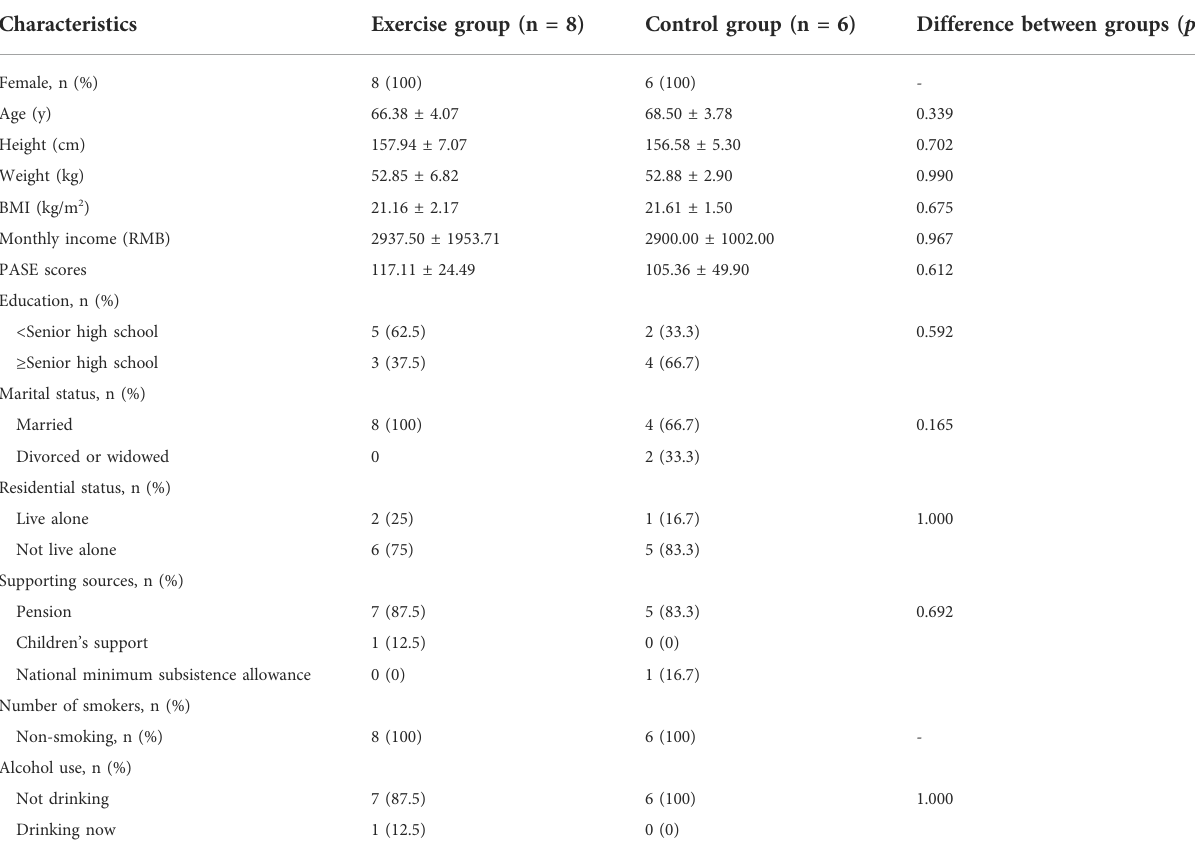
TABLE 1 Demographic characteristics of the participants at